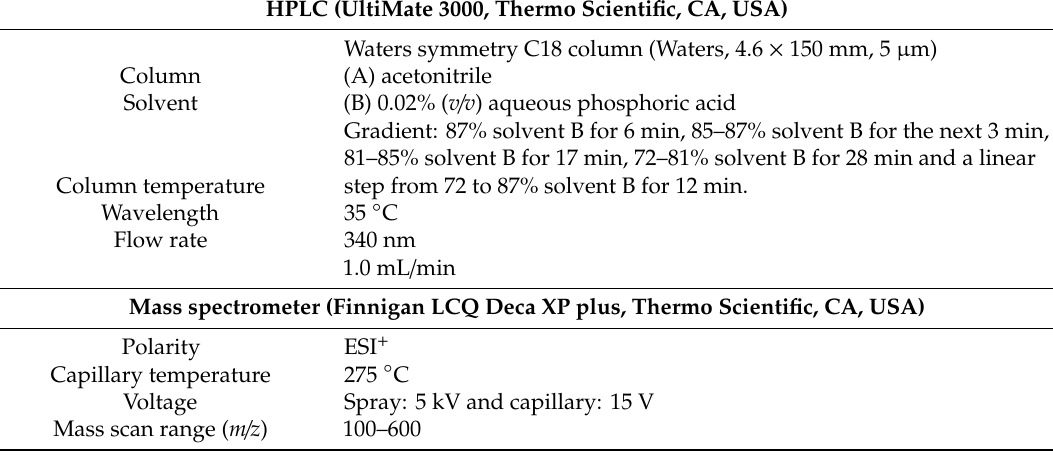
Table 1. High performance liquid chromatography-electrospray ionization–mass